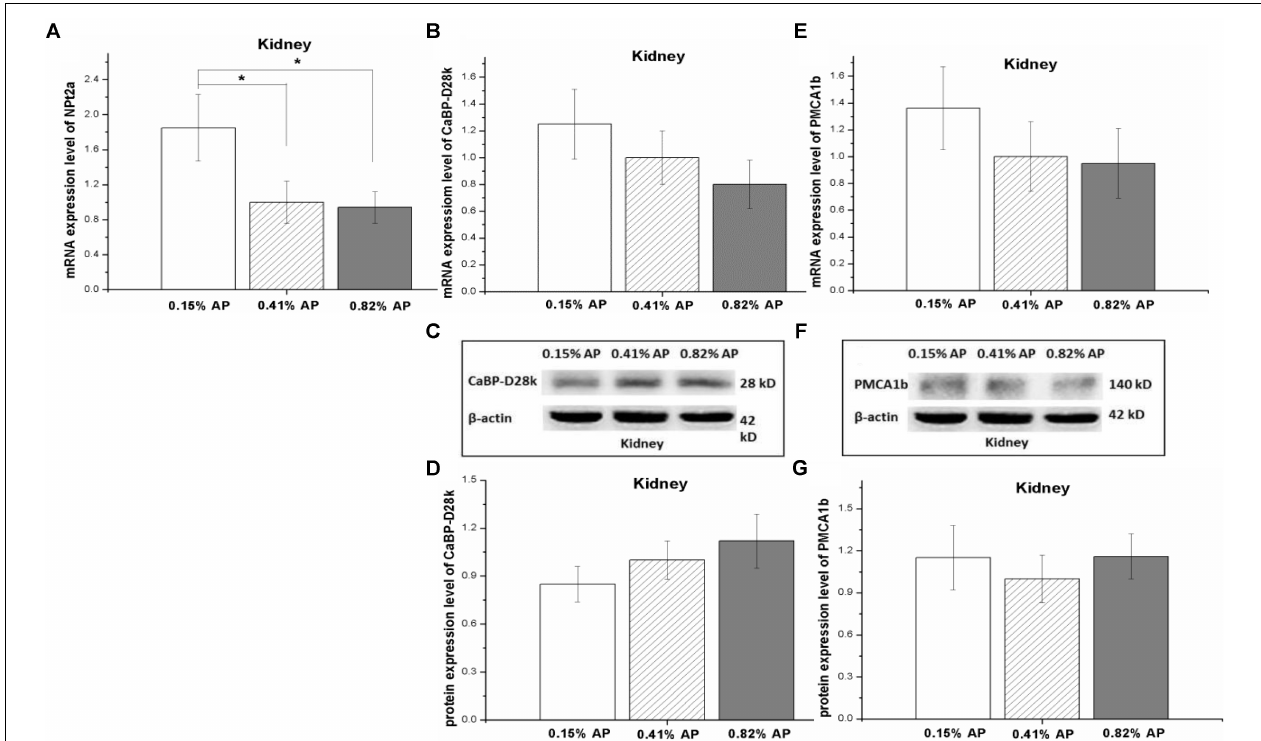
FIGURE 4 | Effect of dietary available phosphorus levels (AP, 0.15, 0.41, and 0.82%) on calcium and phosphorus transporter expression in kidney of laying hens. The mRNA expression level of type II-A Na/Pi co-transporter (NPt2a) (A) ; the mRNA and protein expression levels of Calbindin-D28k (CaBP-D28k) (B–D) ; the mRNA and protein expression levels of plasma membrane calcium ATPase 1b (PMCA1b) (E–G) . The values are presented as the means ± SEM ( n = 8); ∗ P <